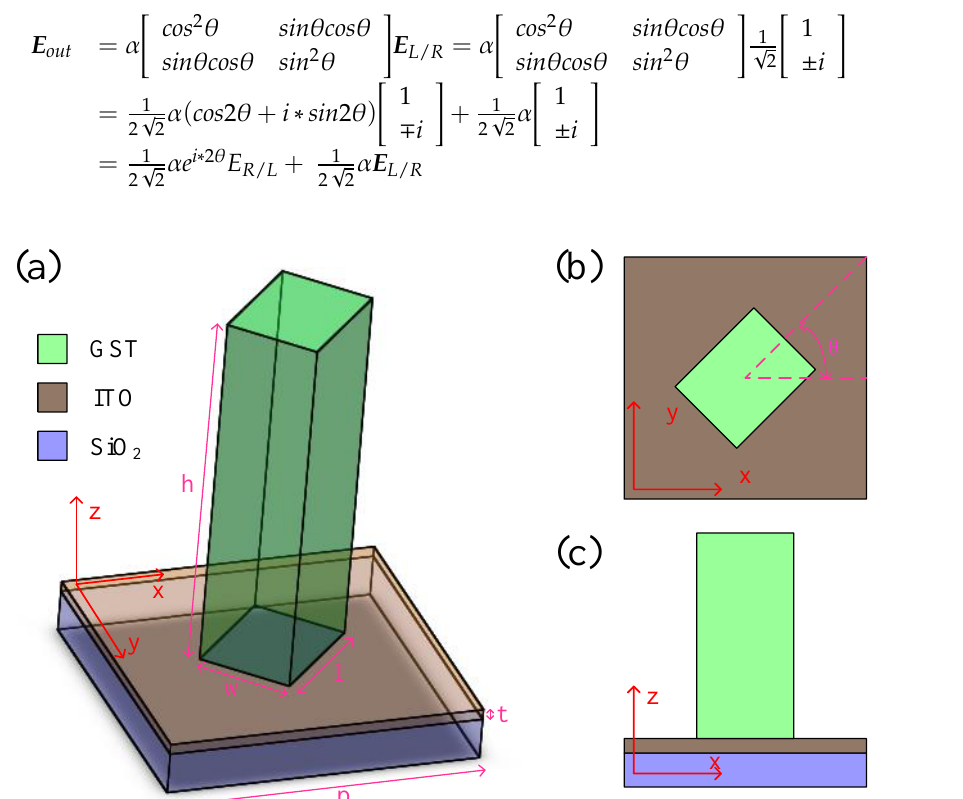
Figure 1. ( a ) Overview of the unit cell. The structured GST with period p , height h , length l , width w is settled on the substrate SiO 2 . A 30-nm thin film ITO is deposited between the GST and substrate as a conductive layer. ( b ) Top view of the unit cell. The structured GST forms an angle θ with x axis. ( c ) Side view of the unit cell.